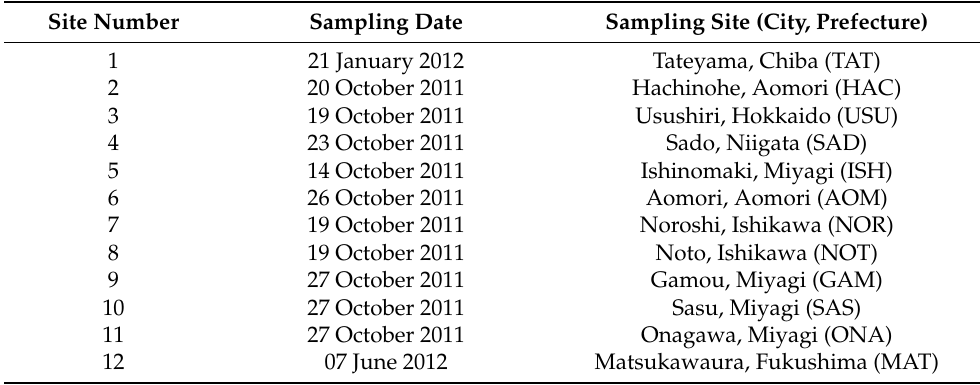
Table 1. Sampling date and location (city,